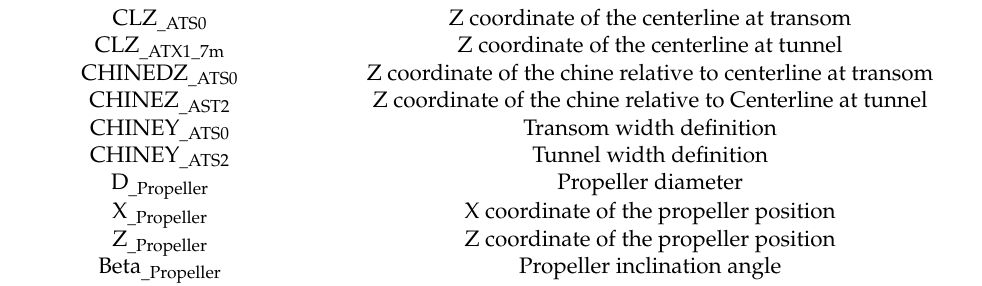
Table 1. Local optimization